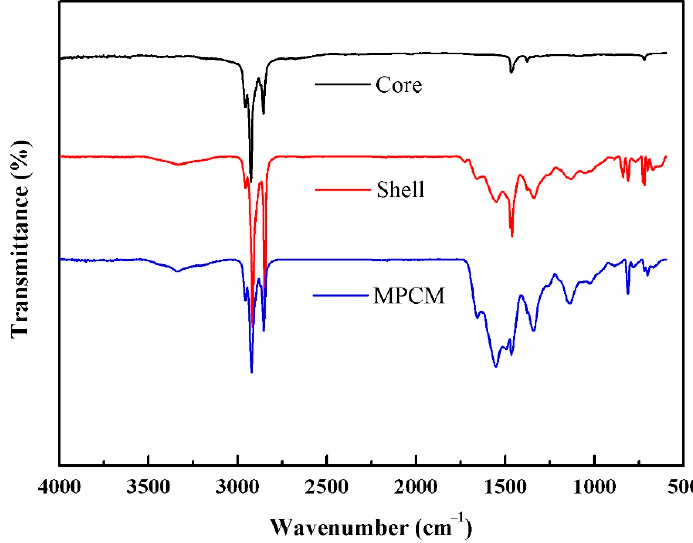
Figure 5. FT − IR spectra of core, shell and MPCM.